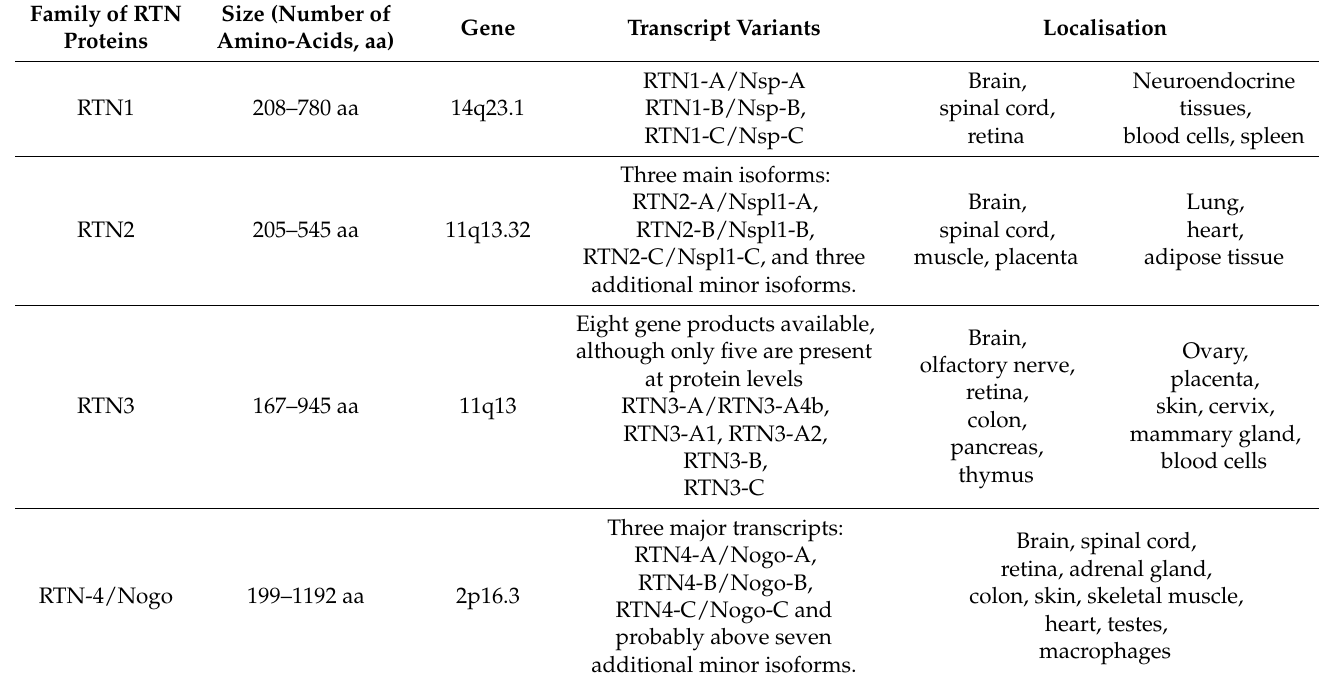
Table 1. Characteristics of the RTN family